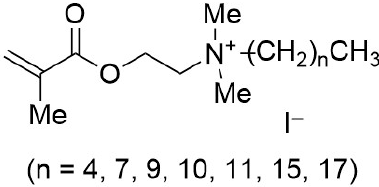
Figure 1. N -Alkyl- N , N -dimethyl- N -[(methacryloyloxy)ethyl]ammonium